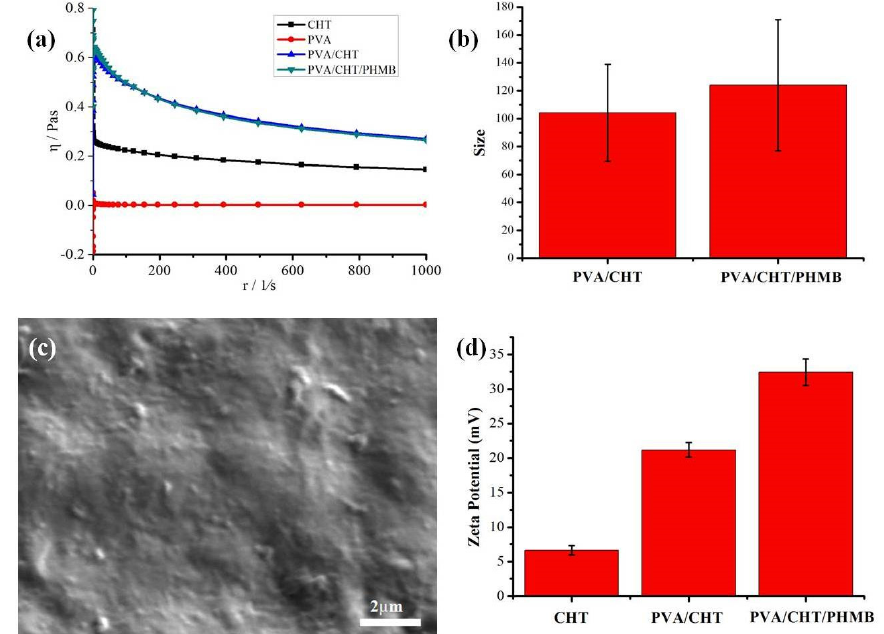
Figure 1. ( a ) The viscosity versus the shearing rate for PVA, CHT, PVA/CHT, PVA/CHT/PHMB solution at 37 °C, ( b ) The size of PVA/CHT and PVA/CHT/PHMB respectively, ( c ) The SEM images of PHMB in PVA/CHT, and ( d ) The zeta potential of CHT, PVA/CHT and PVA/CHT/PHMB respectively.